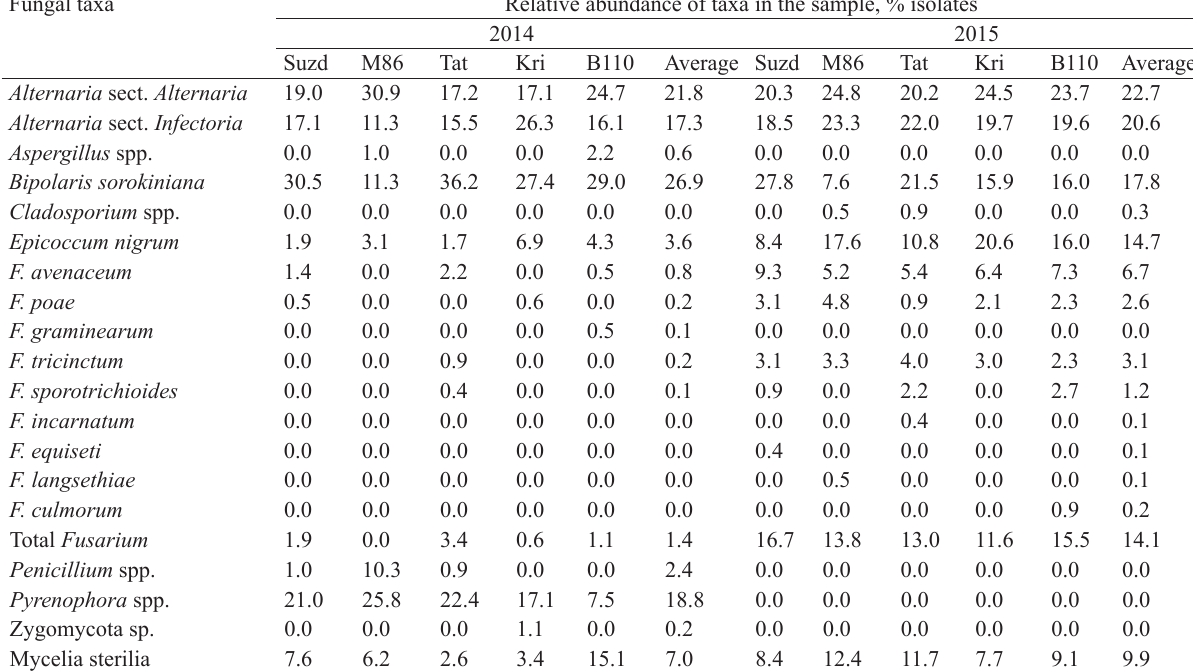
Table 1 Mycological identification of fungi in sterilized barley grains harvested in 2014 and 2015 Fungal taxa Relative abundance of taxa in the sample, % isolates